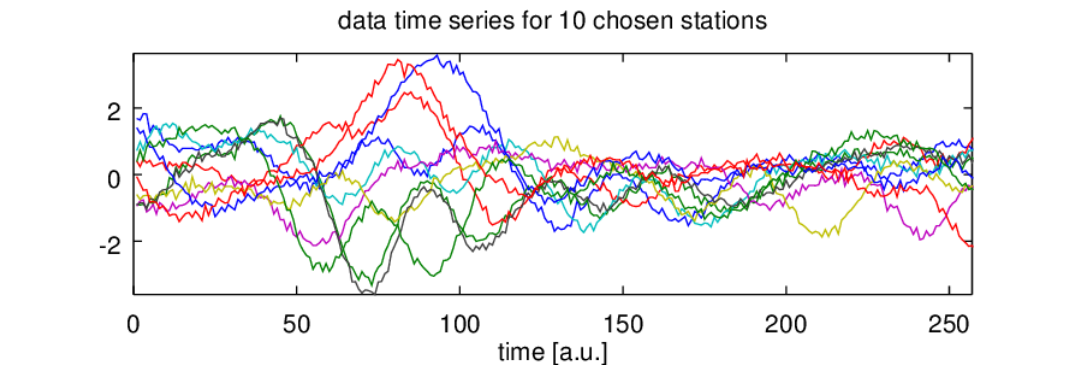
Figure 3. The data sets obtained from virtual receiving stations from Figure